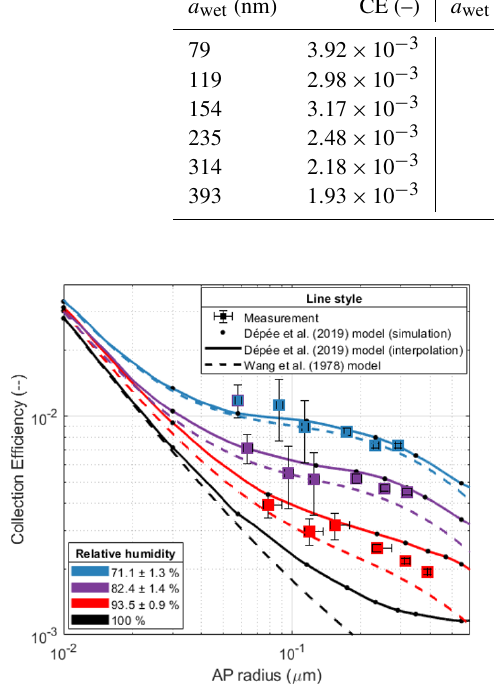
Figure 10. CE measurements for three levels of relative humidity – 71.1%, 82.4% and 93.5% – compared to the extended model of Dépée et al. (2019) (solid lines) and the Wang et al. (1978) model (dashed line). Squares are the CE measurements summarised in Table 3. For the modelling, air temperature and droplet radius are then the mean values of the three levels of relative humidity – T air = 0 . 26, 0.27 and 1.2 ◦ C – A = 49 . 3, 50.8 and 48.8µm – from the lowest to the highest, respectively. For RH = 100%, the param- eters are those from Table